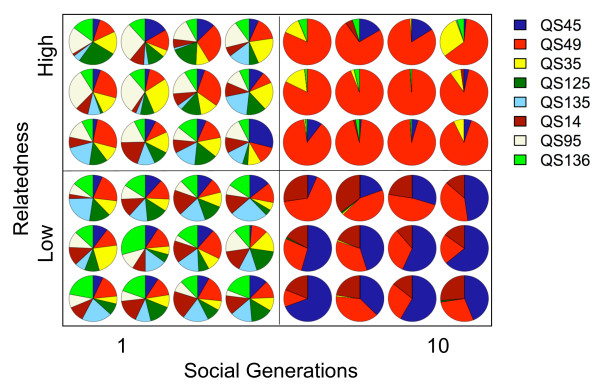
Strain composition changed over time. The frequencies of each strain in twelve populations after one and after ten social generations at high and low relatedness. The eight strains are represented by different colors (QS45 navy blue, QS49 red, QS35 yellow, QS125 dark green, QS135 light blue, QS14 maroon, QS95 white, QS136 light green). Each pie diagram represents a population.